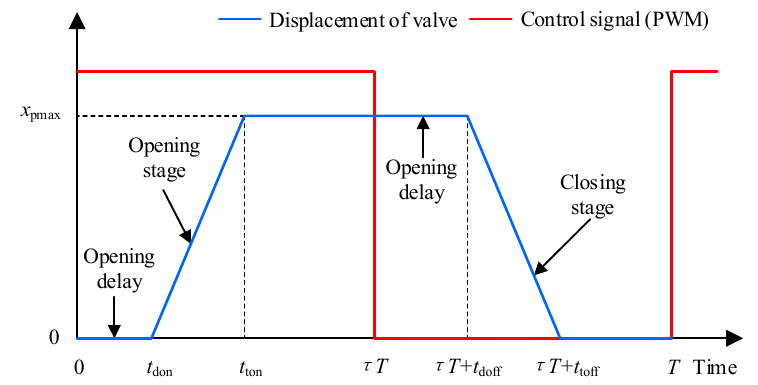
Figure 2. Schematic diagram of the movement of the valve.